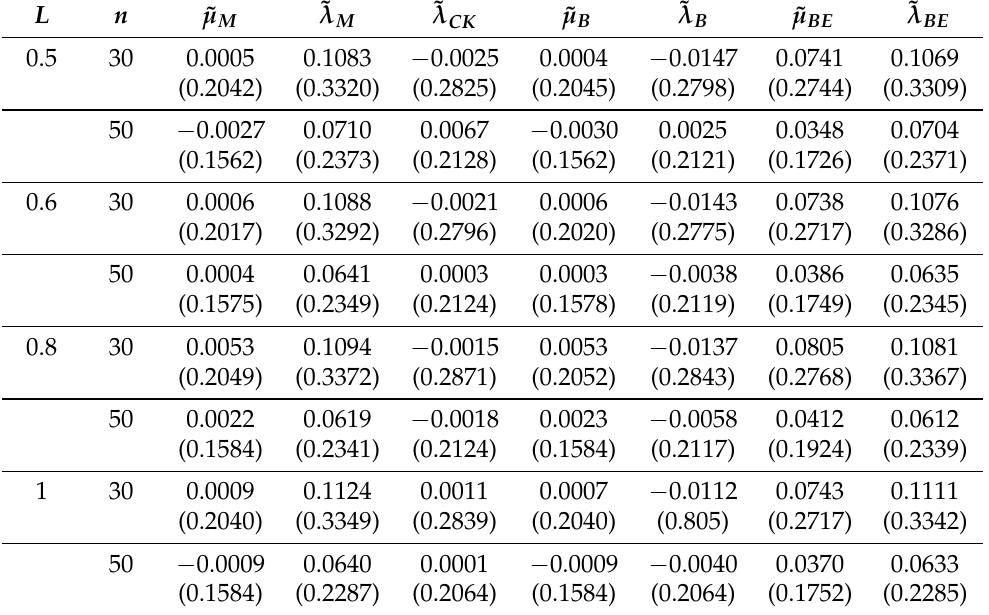
Table 3. The rBias and rRMSEs (in parentheses) of different estimators when µ = 10 and λ =